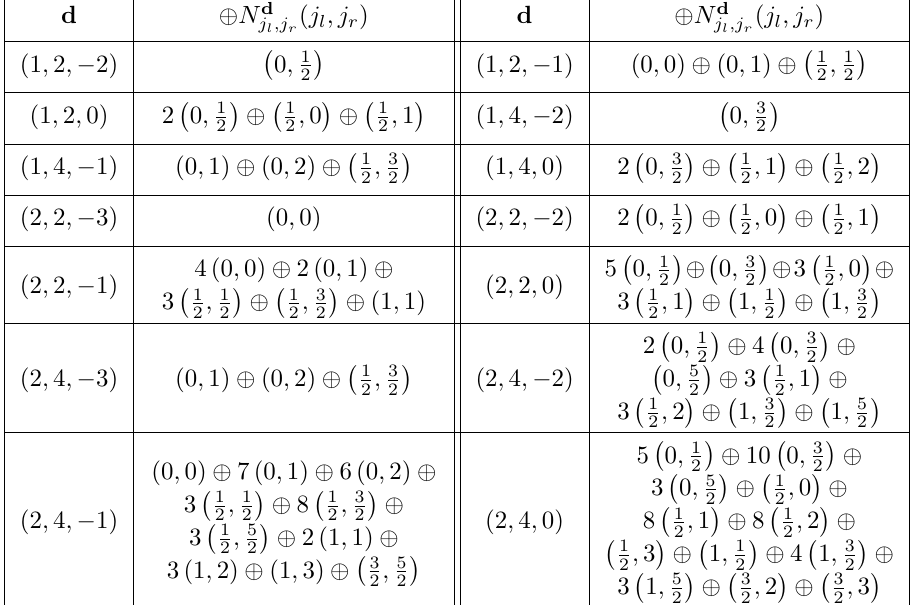
Table 11. BPS spectrum of SU(2) 0 + 1 Adj theory for d 1 ≤ 2 and d 2 ≤ 4 . Here, d = ( d 1 , d 2 , d 3 ) labels the BPS states with charge d 1 m 0 + d 2 φ + d 3 m 1 . The states related by the symmetry d 3 ↔ − d 3 are omitted in the